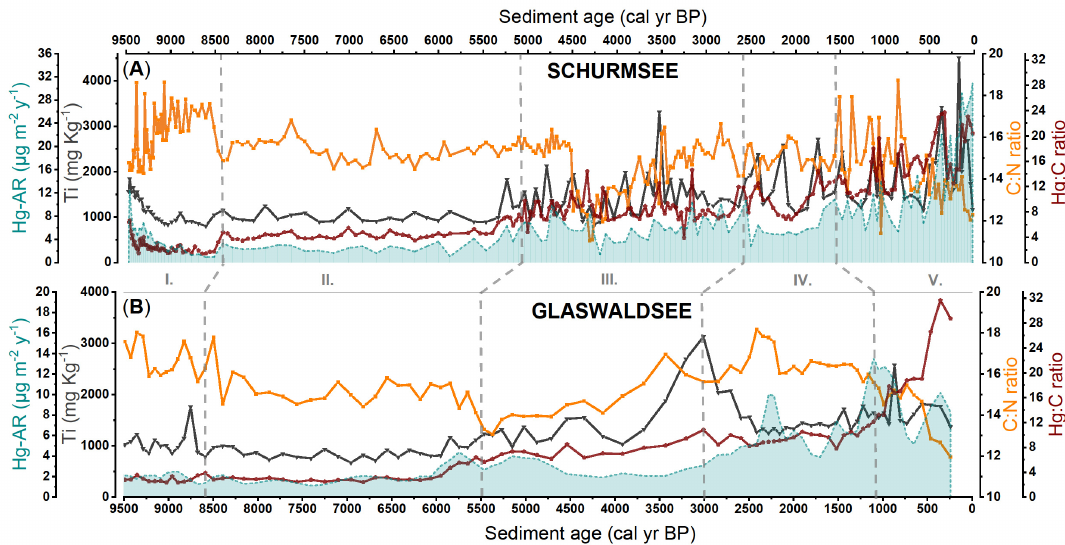
Figure 3. Titanium concentrations (dark-grey line) as indicators of mineral matter erosion, carbon/nitrogen ratios (orange line) as indicators of organic matter sources and observed mercury accumulation rates (grey-blue area), mercury/carbon ratios (dark red line) as an indicator of the interaction of atmospheric Hg fluxes and organic matter sources for Schurmsee ( A ) and Glaswaldsee ( B ) by linear age-depth